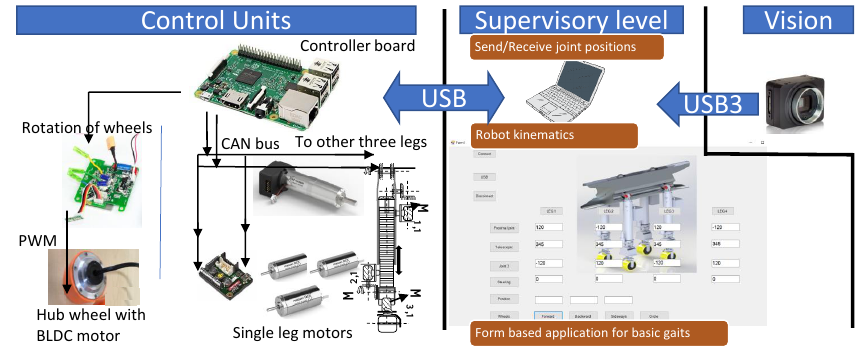
Figure 7. System diagram of Tarantula .